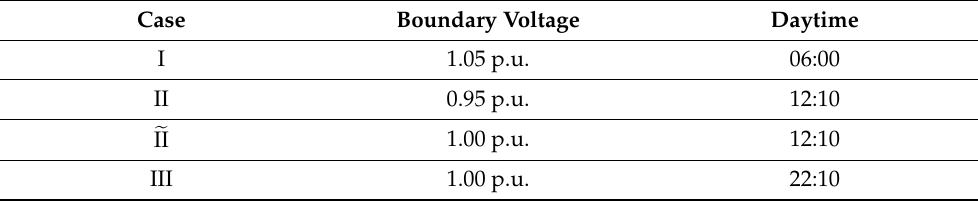
Table 2. Voltage − time-pairs of the test cases discussed in detail.